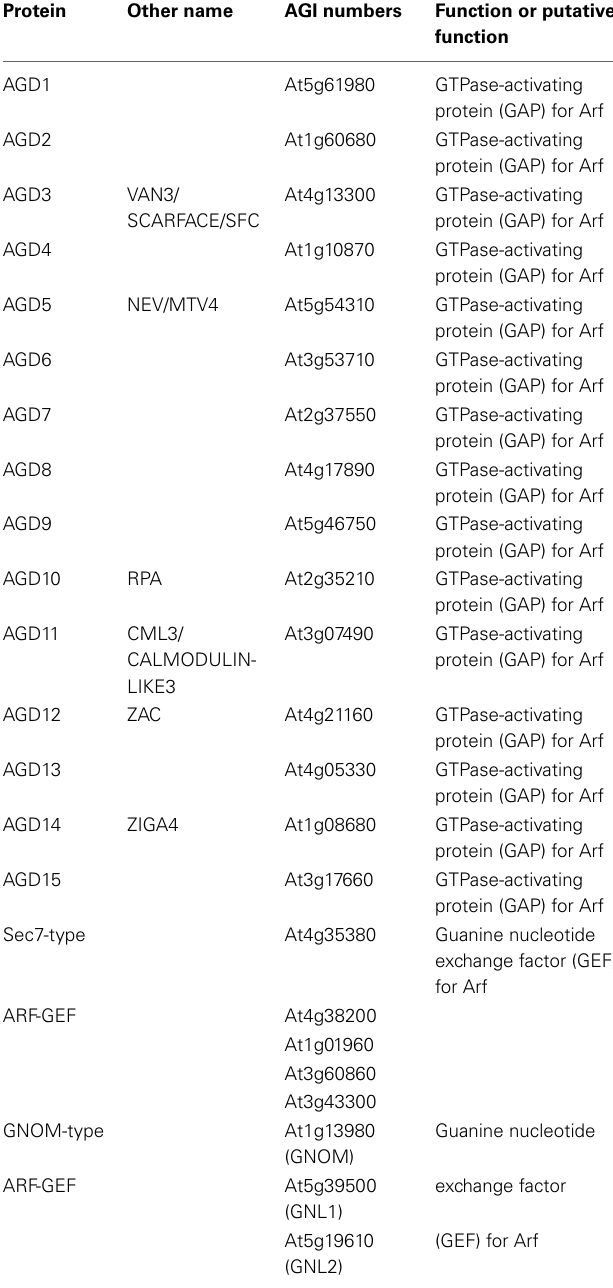
Table 3 | Regulators for Arabidopsis Arf